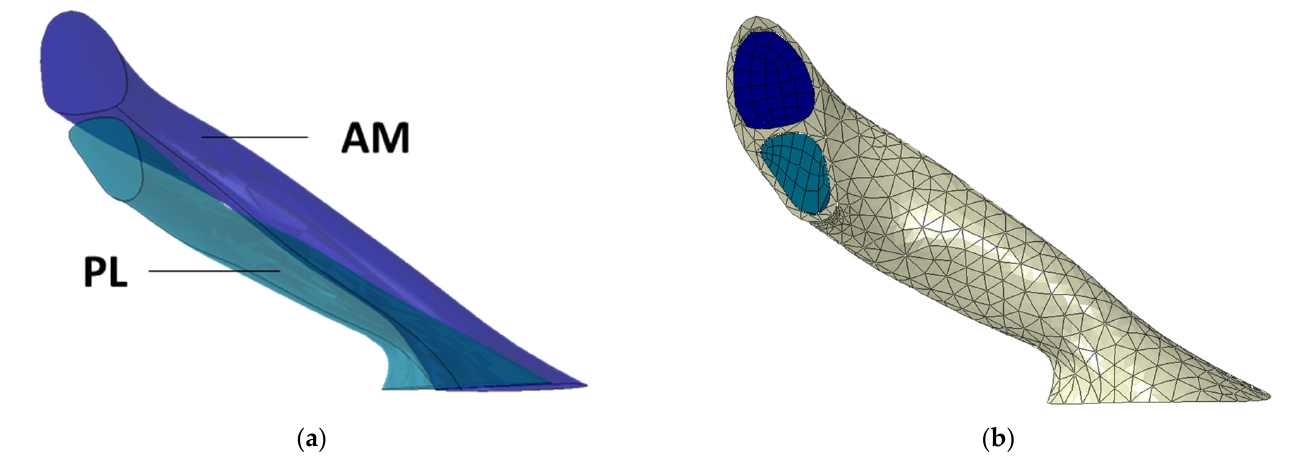
Figure 3. ( a ) Geometry of the AM and PL bundles, ( b ) Complete ACL mesh (bundles and connective tissue).